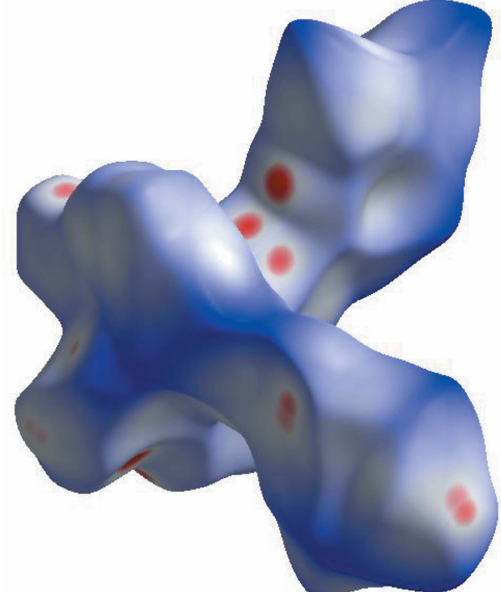
Figure 3 A projection of d norm mapped on the Hirshfeld surface, showing the intermolecular interactions within the molecule. Red areas represent regions where contacts are shorter than the sum of the van der Waals radii, blue areas represent regions where contacts are larger than the sum of van der Waals radii, and white areas are regions where contacts are close to the sum of van der Waals radii.